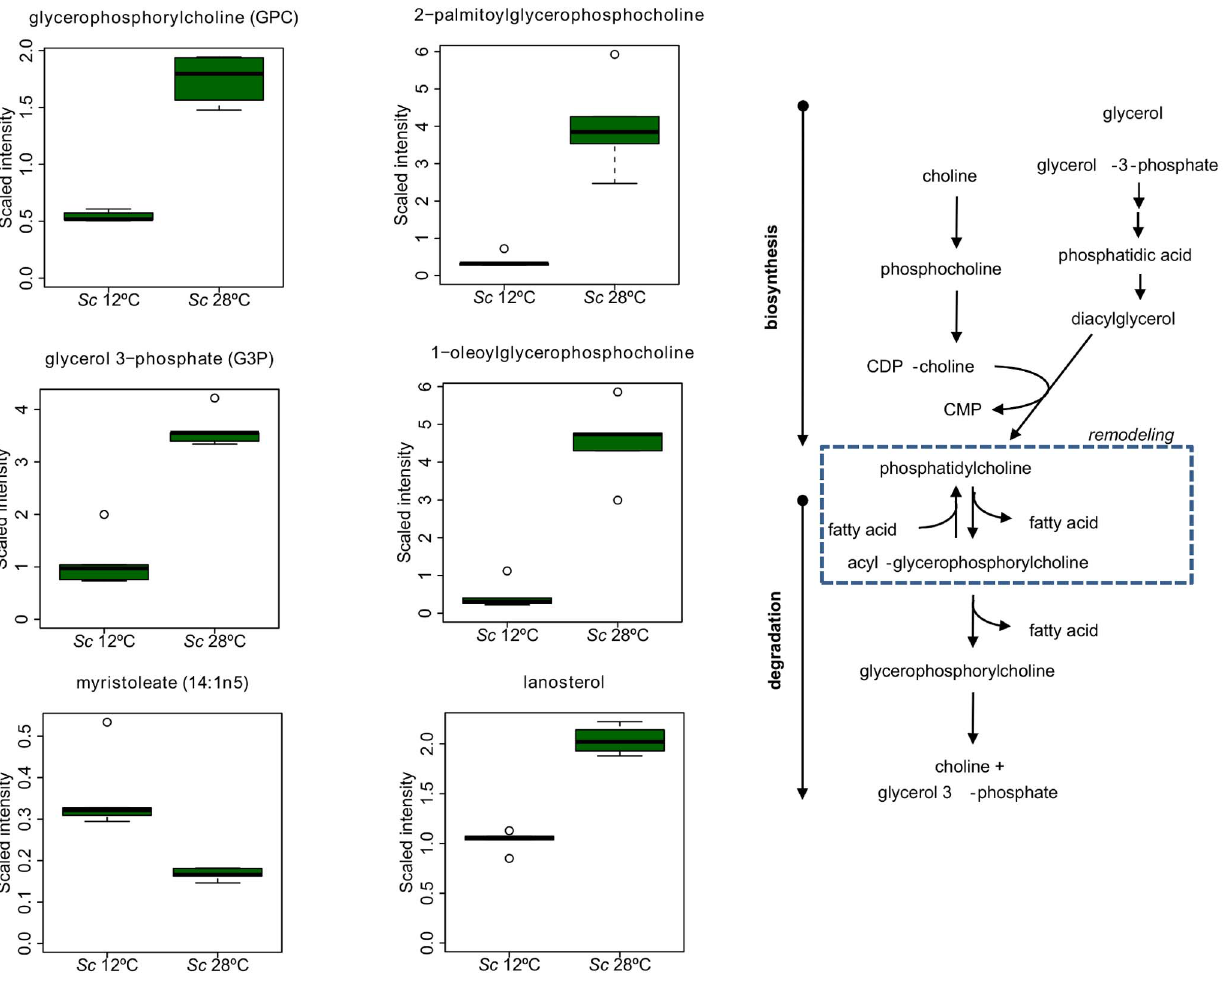
Figure 4. Phosphatidylcholine biosynthesis and degradation in S.cerevisiae . Metabolic differences in the Sc growing at 12 u C and 28 u C. Box legend: bar inside the box represents the median value, upper bar represents maximum of distribution, lower bar represents minimum of distribution and the circle represents extreme data points.